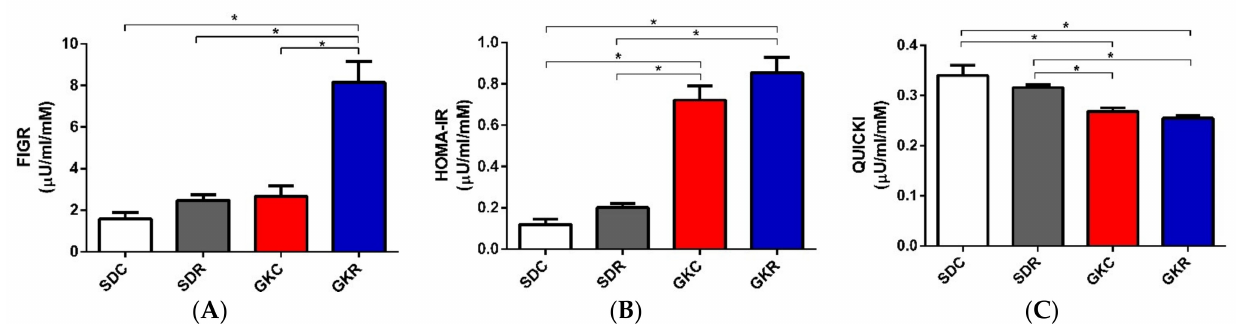
Figure 1. Effects of resveratrol on fasting insulin/glucose (FIGR) ( A ), homeostatic model assessment—insulin resistance (HOMA-IR) ( B ), and quantitative insulin sensitivity check index (QUICKI) ( C ) in SD and GK rats. To calculate these indices, rats were fasted 12 h before taking blood for measurement glucose and insulin levels. SDC—Sprague-Dawley control rats, SDR—Sprague-Dawley rats treated with resveratrol, GKC—Goto-Kakizaki control rats, GKR—Goto-Kakizaki rats treated with resveratrol. Results represent the means ± SEM from 10 rats. *—Differences statistically significant ( p < 0.05).